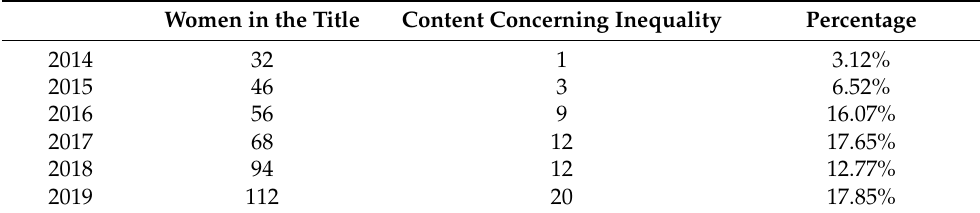
Table 1. Evolution of content addressing the inequality of women in science.